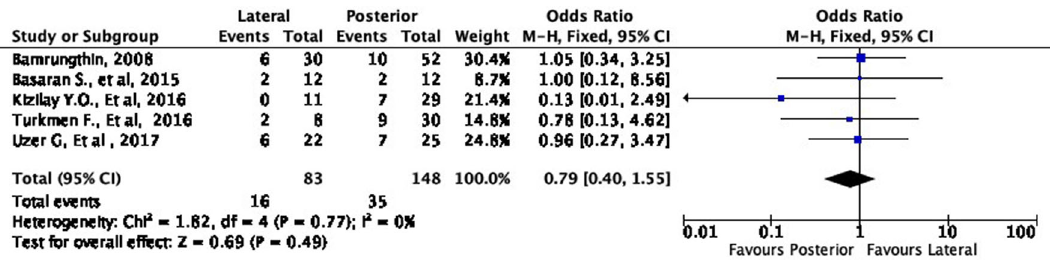
Figure 9. Comparison of functional outcome in the good subgroup.